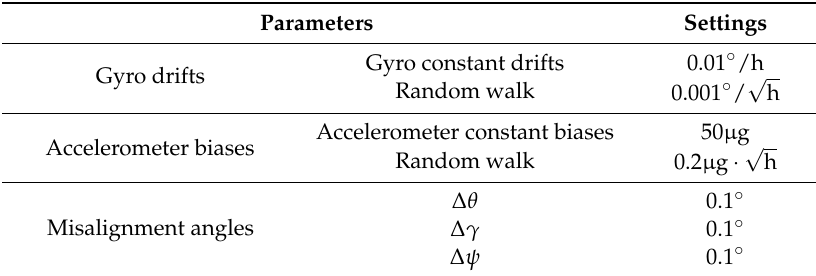
Table 1. Settings of inertial device biases and misalignment angles.